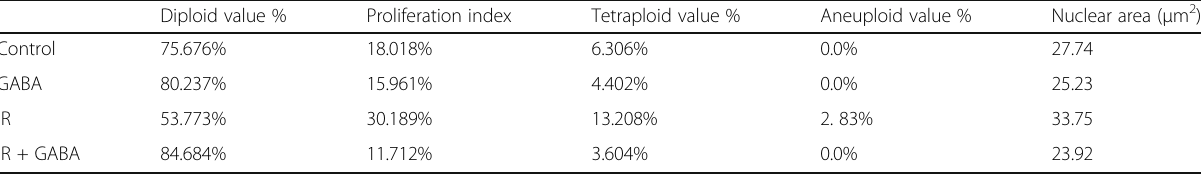
Table 2 DNA cytometry parameters in the studied